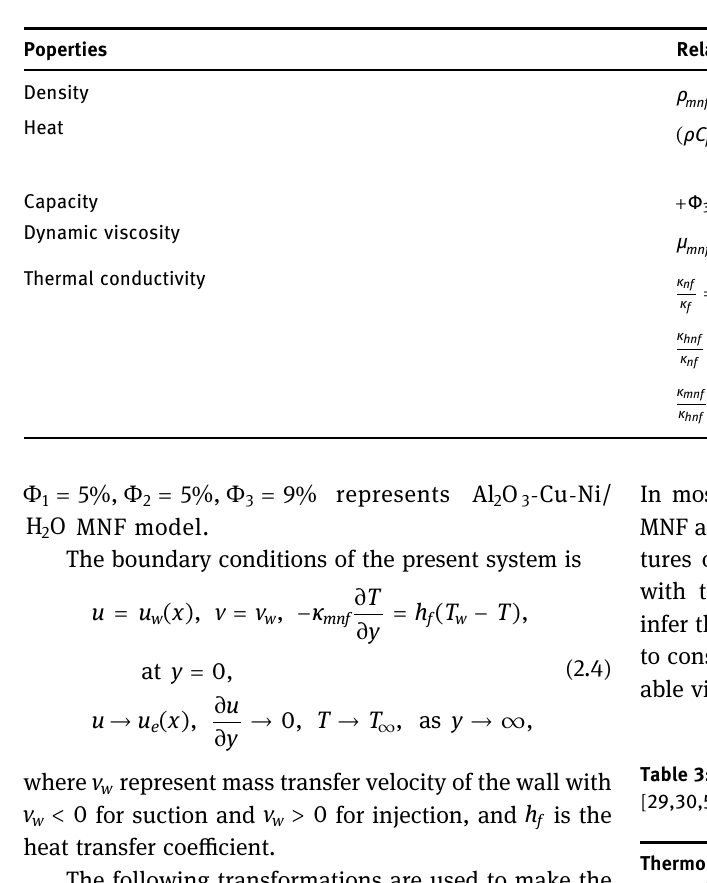
Dynamic viscosity Thermal conductivity